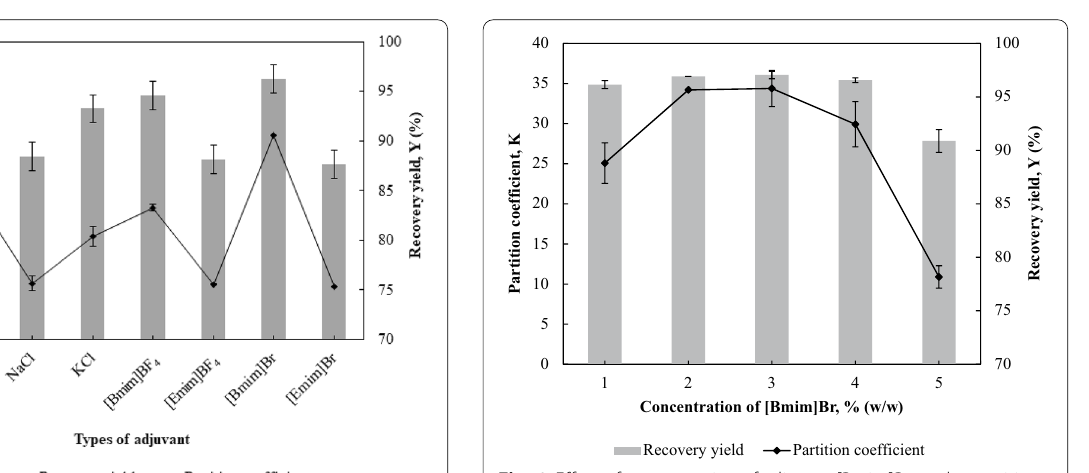
Fig. 6 Effect of concentration of adjuvant [Bmim]Br on the partition efficiency of BSA. The effect of [Bmim]Br’s concentration ranging from 1.0% (w/w) to 5.0% (w/w) on the K and Y of BSA was evaluated. The results are expressed as mean standard deviation of triplicate ± standard deviation ±